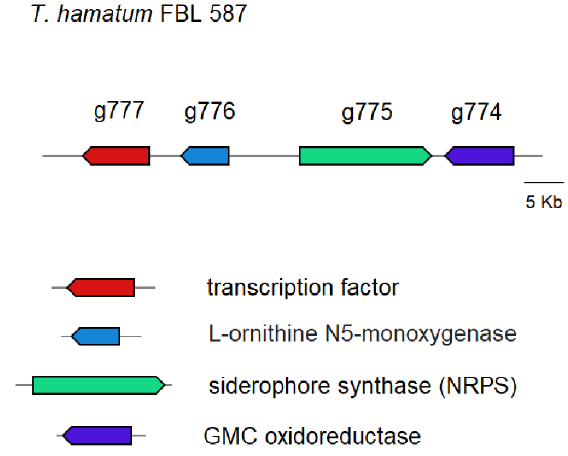
Figure 4. The putative ferricrocin siderophore gene cluster in the genome of T. hamatum FBL 587 consisted of four genes, which encode for an GMC oxidoreductase (ProtID g774), a (NRPS) ferri- crocin synthase (ProtID g775), a L-Ornithine-N5-oxygenase (ProtID g776), and a transcription factor (ProtID g777). Gene clustering is represented by the arrows superposed on the horizontal black line. Intergenic spaces are not drawn in scale.